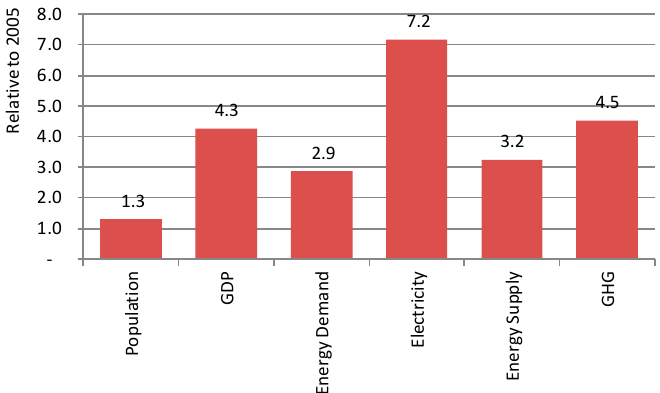
Figure 3. Socio-economic factors, energy, and GHG emissions under the baseline scenario in 2030 relative to 2005. GDP: gross domestic product; GHG: greenhouse gas.